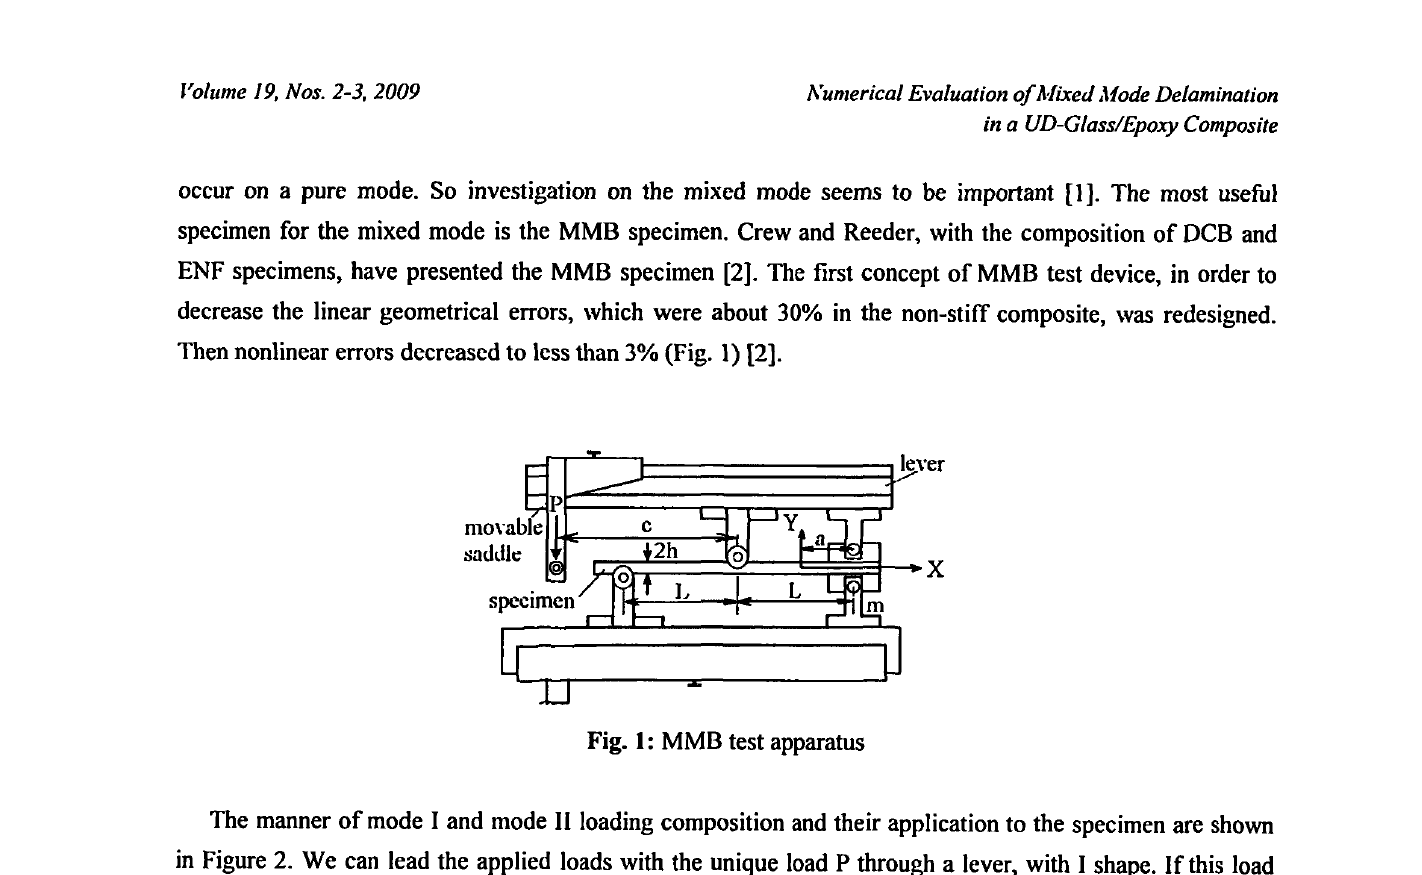
Fig. 1: MMB test apparatus